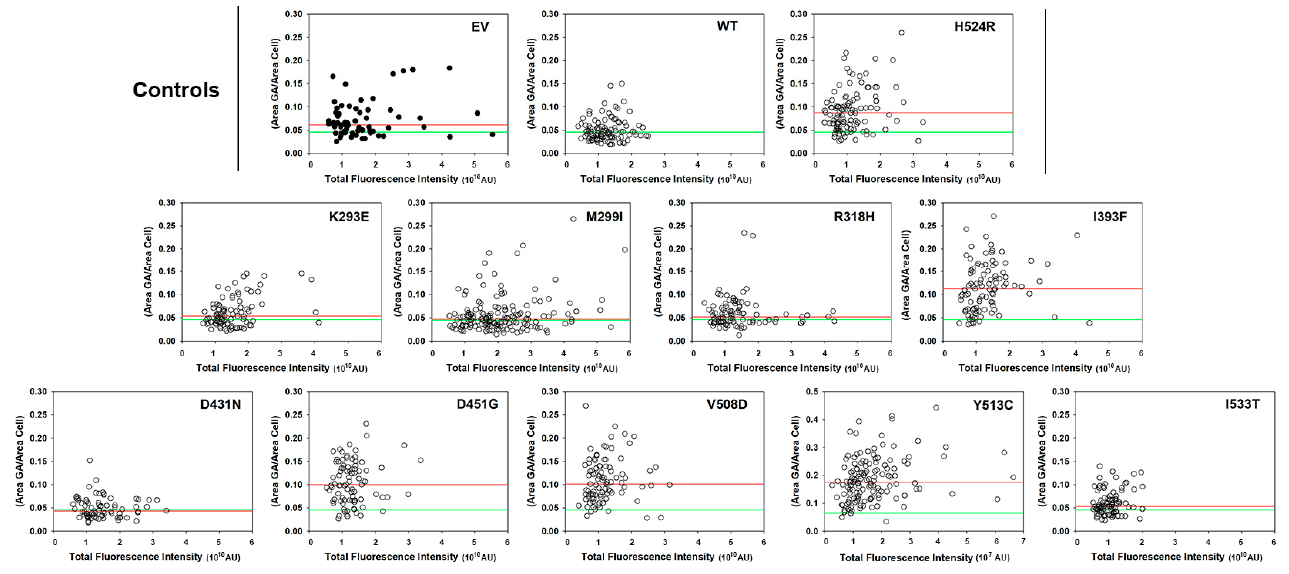
Figure 5. Golgi apparatus fragmentation phenotype induced by OCRL1 VAR as function of each variant intracellular content. Results in a representative experiment for the evaluation of GA frag- mentation induced by the indicated OCRL1 VAR . The ratio (Area GA/Area cell) was estimated as described in Material and Methods and Figure 4. 150–200 cells HK2 OCRL1 KO cells expressing only GFP (i.e., transfected with pEGFP empty vector, EV) or GFP-OCRL1 WT/VAR were analyzed per sample while also measuring their total fluorescence intensity in arbitrary units reporting total amount of the indicated protein present in the corresponding cells). Green horizontal dashed line depicts the median value obtained for cells only expressing OCRL1 WT , while the red reference line corresponds with the median value measured for each specific OCRL1 VAR